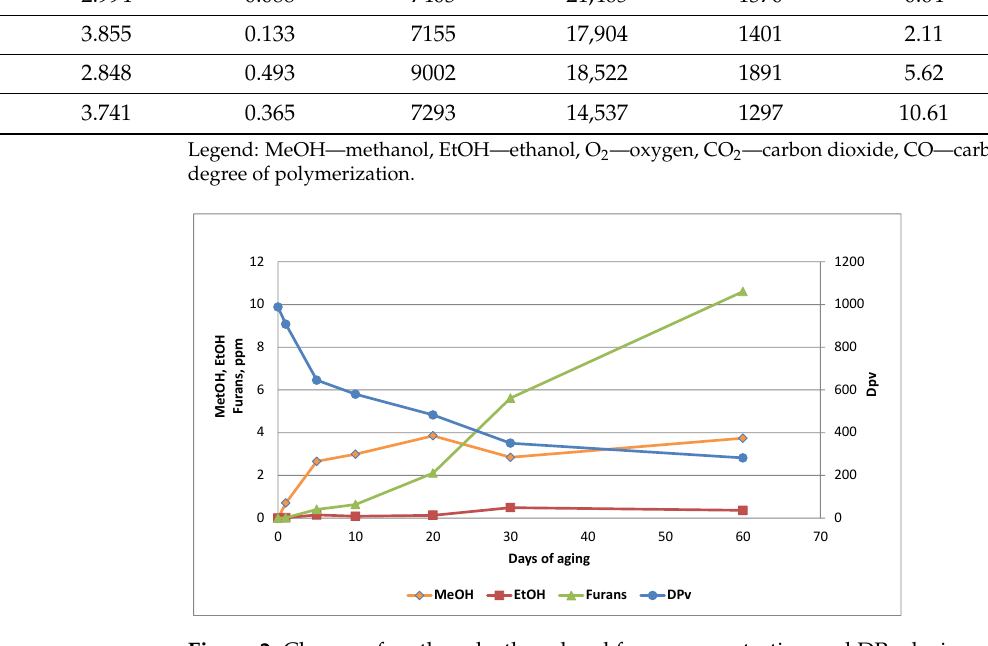
Figure 2. Change of methanol, ethanol and furan concentration and DP v during aging experiment II at 120 °C.